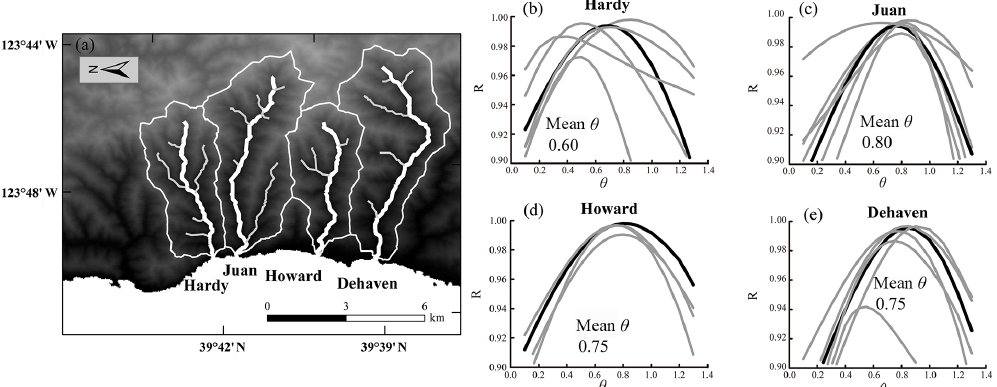
Figure 13. Correlation coefficients of χ − z plots as a function of θ . (a) Location of the streams. Streams are extracted with a critical area of 0.5km 2 . (b–e) Correlation coefficients of χ − z plots based on a range of θ values. Black thick lines indicate